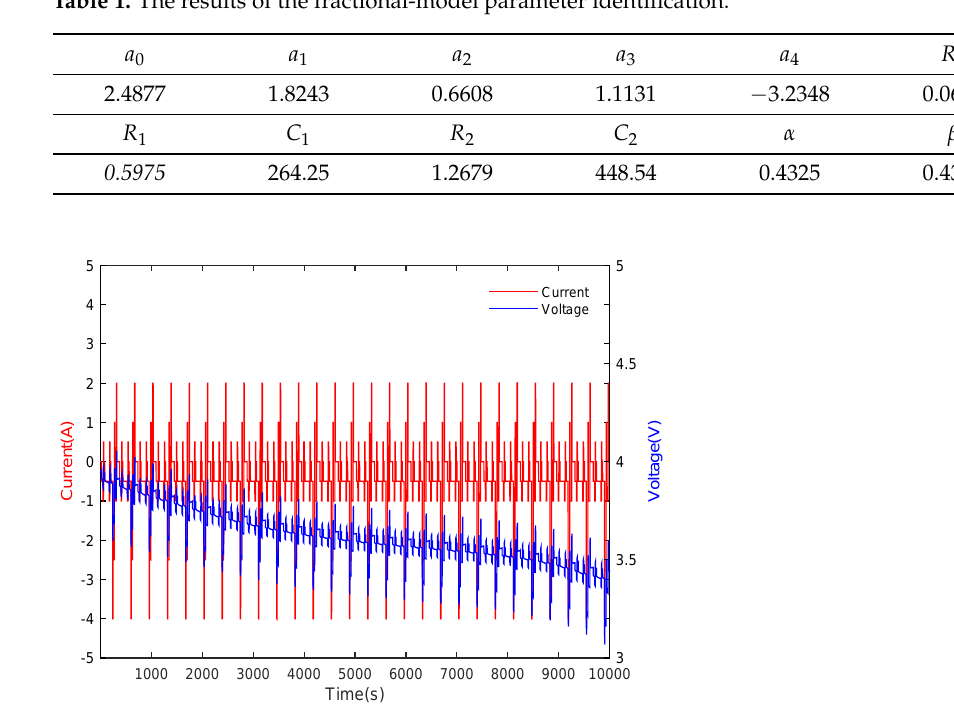
Figure 2. Current and voltage profiles of the operation conditions: